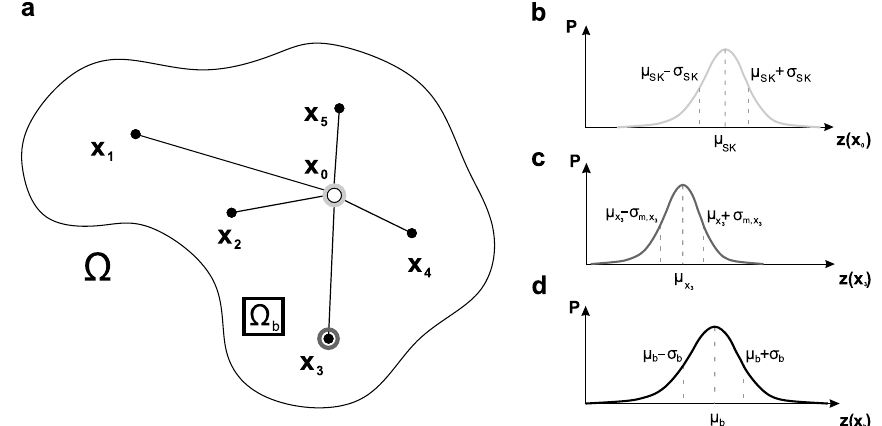
Figure 2. Schematic of the uncertainty components integrated into a predictive model of rock properties. ( a ) Illustration of an interpolation process using neighboring points x k with known values to predict the unknown value at x 0 . ( b – d ) Schematic of the local probability density functions (PDFs) in form of a Gaussian distribution defined by σ 2 and µ for the estimated kriging error variance σ 2 observed measurement error σ 2 m at the point x 3 ( c ) and the observed variance σ 2